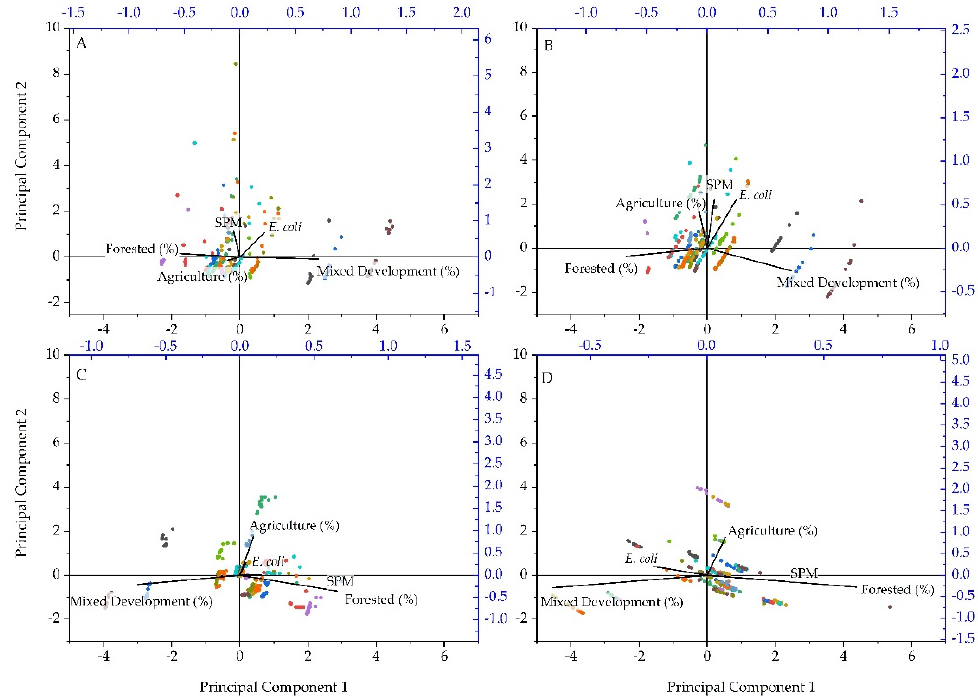
Figure 9. Results of principal component analysis, including biplots, for extracted principal components of quarterly E. coli concentration (CFU per 100 mL) and quarterly SPM concentration (mg/L) at each sampling location (n = 22) during the study period (2 January 2018–1 January 2019) in West Run Watershed, WV, USA. Note: ( A ) represents Quarter 1 (winter: 2 January 2018–27 March 2018); ( B ) represents Quarter 2 (spring: 3 April 2018–26 June 2018); ( C ) represents Quarter 3 (summer: